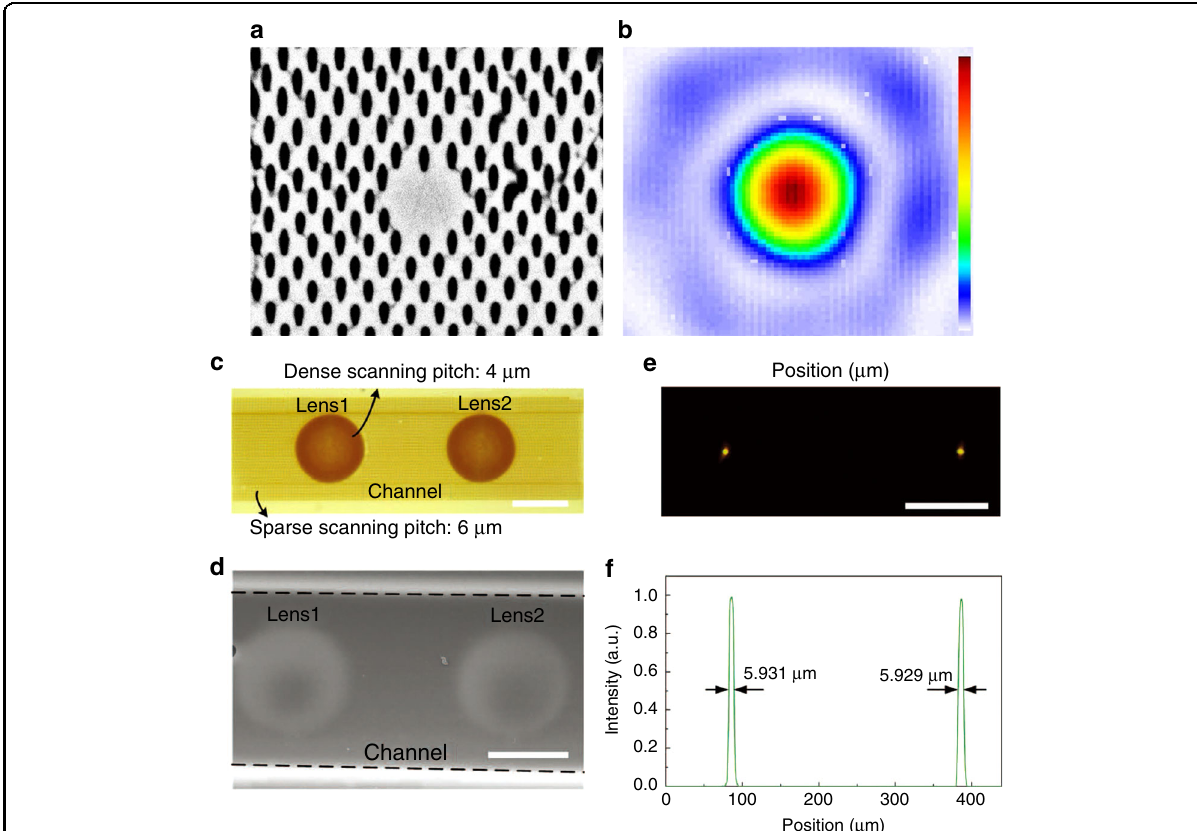
Fig. 13 Fabrication of micro-optical devices and integration of multiple components inside transparent materials. a , b Nanostructured waveguide fabricated in YAG crystal and Diffraction-limited near- fi eld image of the waveguide output mode measured at 1550 nm 129 . c , d Optical microscopy and SEM images of the glass micro-lens integrated into micro-channel 139 . e , f Focusing characteristics of the glass micro-lens in a micro- channel in air. Scale bars: 100 μ m. Figures reproduced from ( a , b ) ref. 129 , ©2020 Springer Nature Limited; c – f ref. 139 , ©2018 WILEY-VCH Verlag